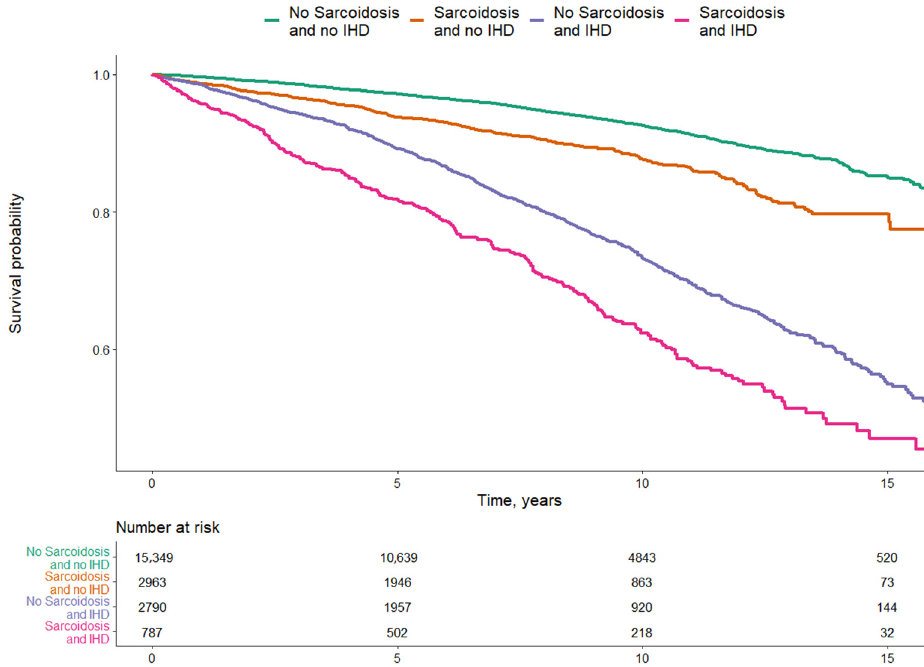
Figure 2. Multivariate analysis of survival probability over a period of 15 years among sarcoidosis patients with and without IHD and controls without sarcoidosis and without IHD.